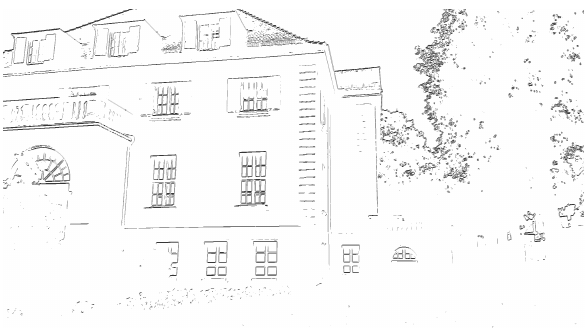
Figure 9: Edge image after application of the modified Prewitt operator (chapter